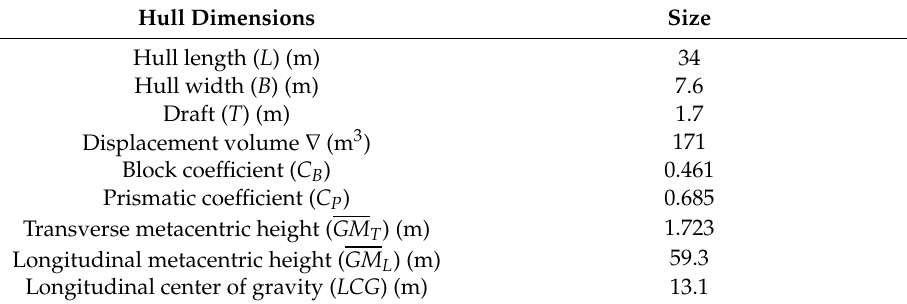
Table 1. Specifications of the series 62